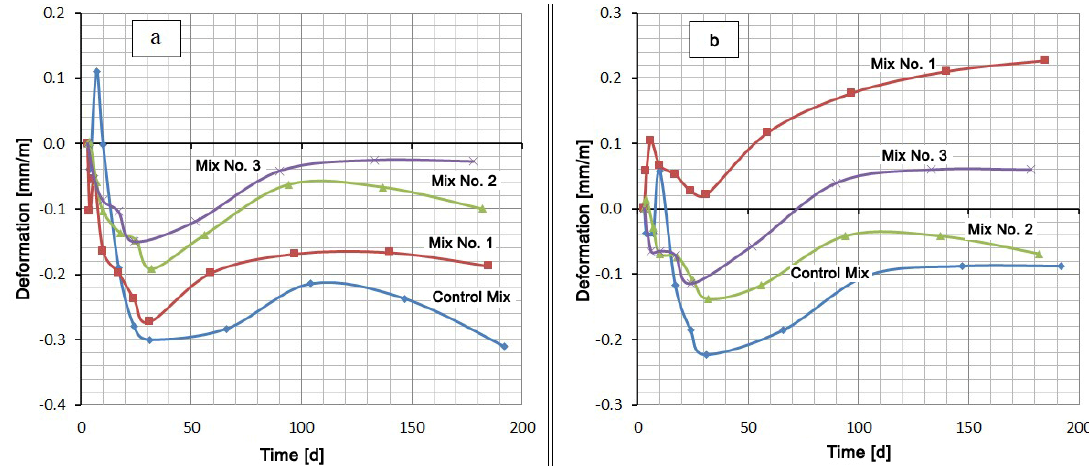
Figure 3. Shrinkage and expansion of compositions in time: ( a ) at water hardening; ( b ) at 5% Na 2 SO 4 solution hardening.